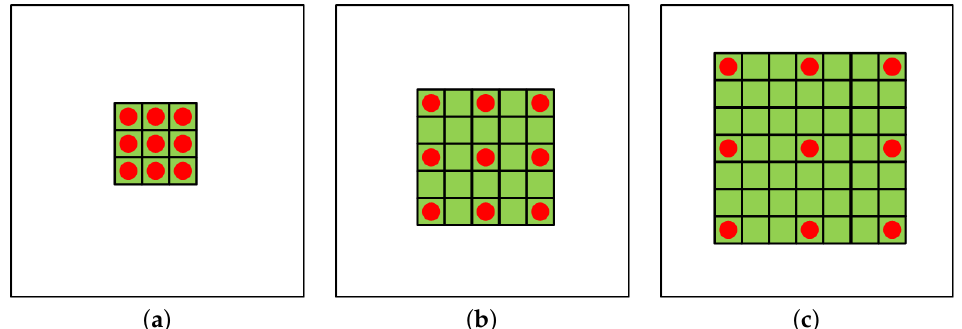
Figure 1. Receptive field of a dilated convolution. ( a ) 1-dilated convolution (conventional convolu- tion) with kernel size 3 × 3 has a 3 × 3 receptive field. ( b ) 2-dilated convolution with kernel size 3 × 3 has a 5 × 5 receptive field. ( c ) 3-dilated convolution with kernel size 3 × 3 has a 7 × 7 receptive field.